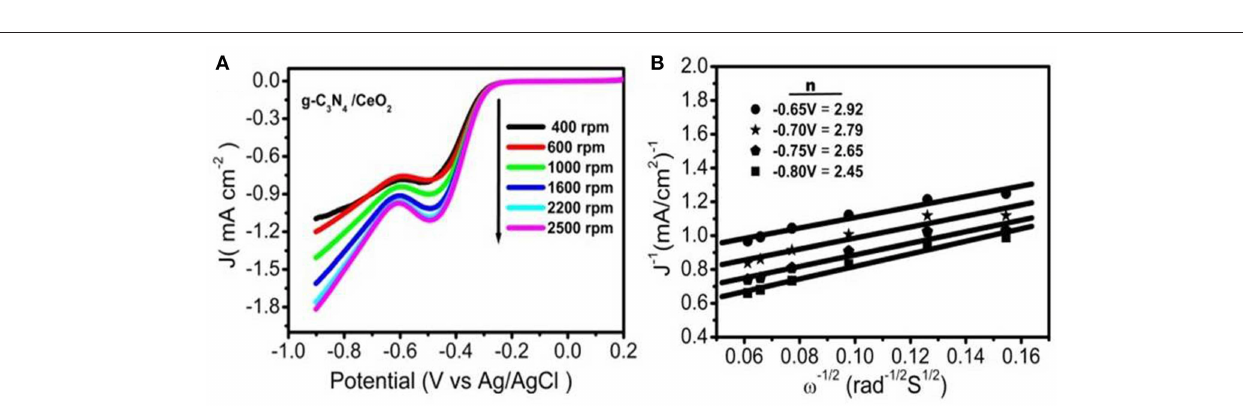
FIGURE 5 | (A) RDE of CeO 2 /g-C 3 N 4 at various rotation rates, (B) K-L plot of CeO 2 /g-C 3 N 4 at different